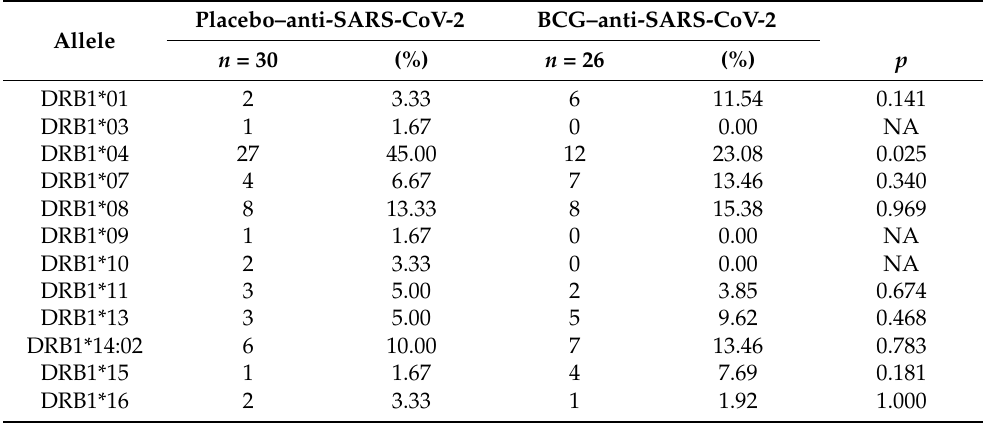
Table 3. Allele frequency among Placebo–anti-SARS-CoV-2 and BCG–anti-SARS-CoV-2 subjects.